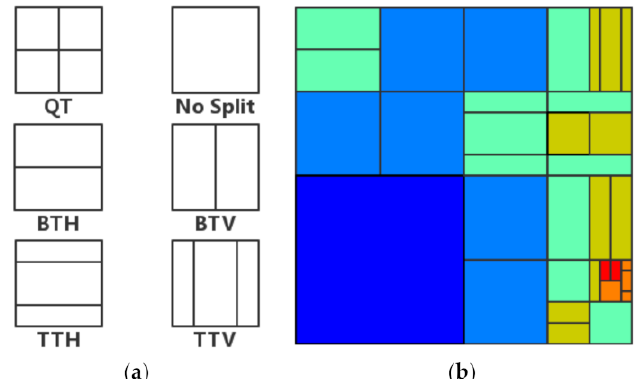
Figure 1. CTU partition with a QTMT partition structure: ( a ) CU split modes; ( b ) example of CTU